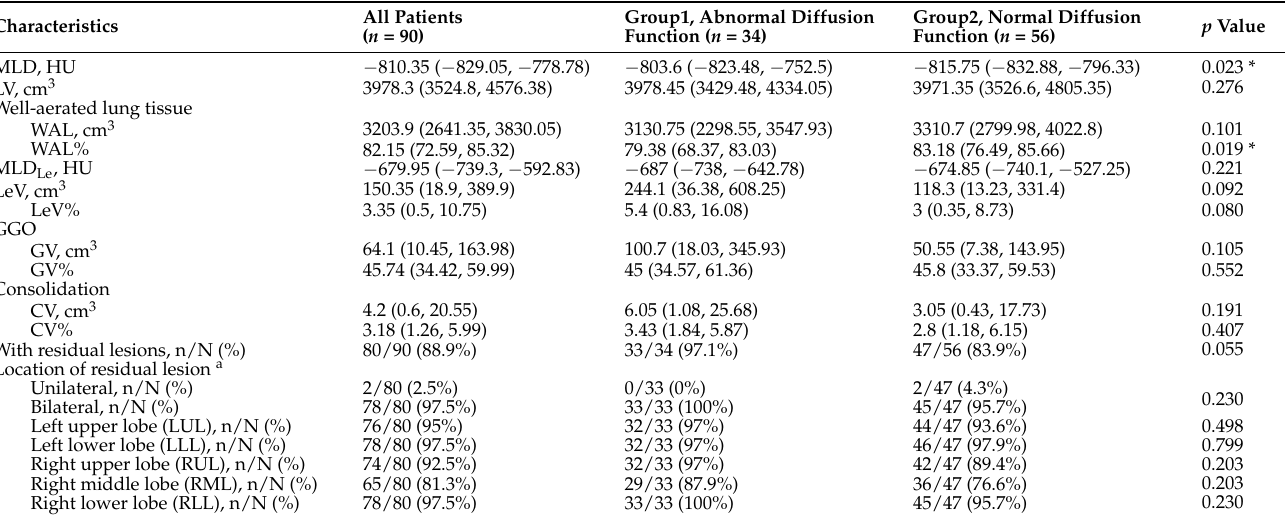
Table 2. The total lung tissue quantitative CT indexes of COVID-19 patients at